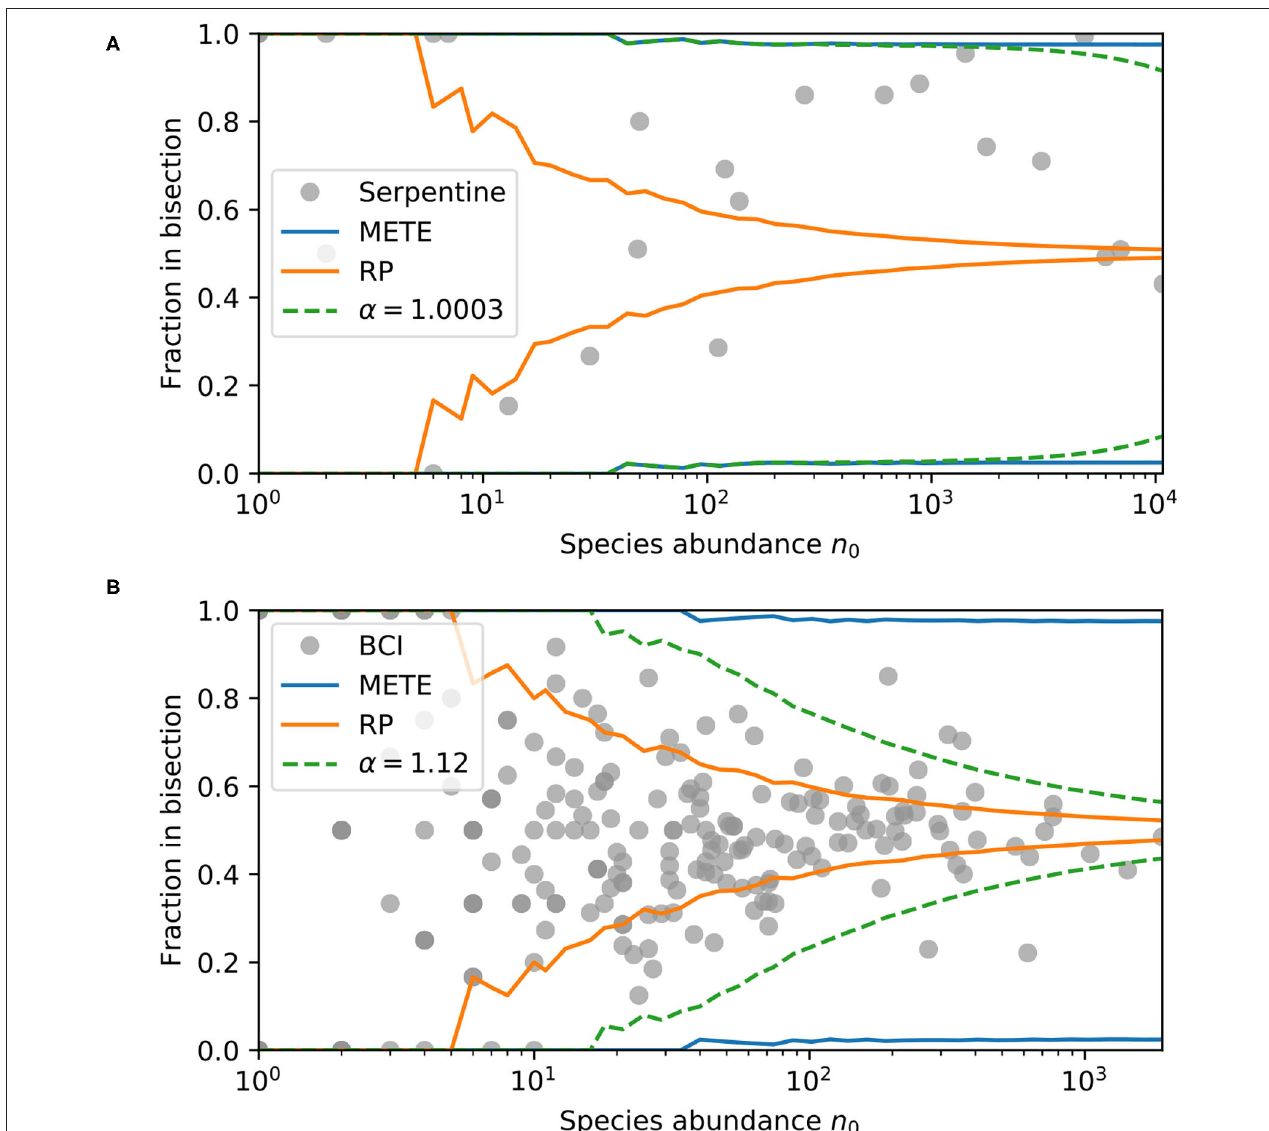
n 0 ) from METE, random placement, and our density | 1.0003 maximizes the log-likelihood for the serpentine dataset, and α 1.12 maximizes log-likelihood = =